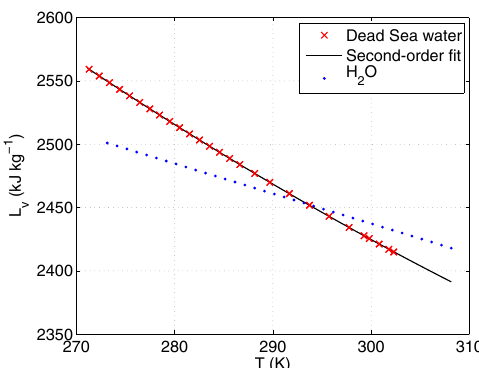
Figure B1. Dependency of the specific latent heat of vaporisation ( L v ) on temperature. Measurements of L v for the saline water of the Dead Sea, a second-order polynomial fit, and literature values for pure water (H 2 O) are